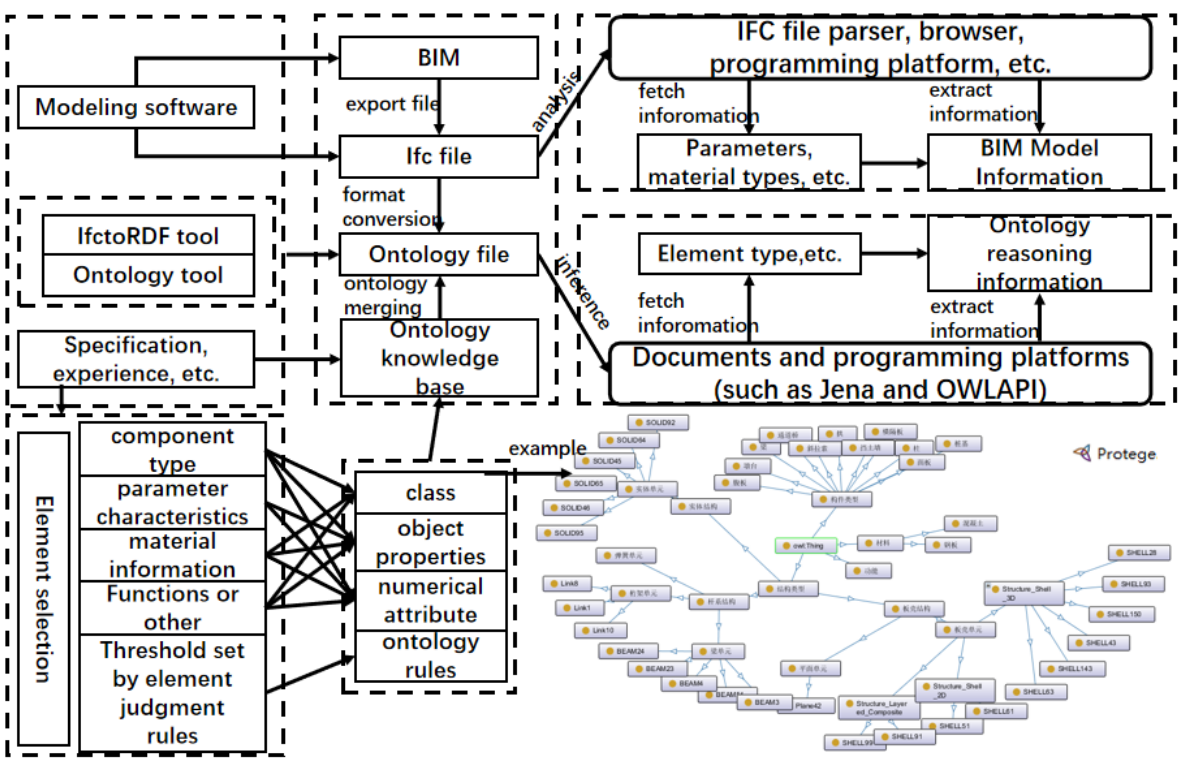
Figure 5. Framework of construction idea of the element type, data conversion, inference, and extraction based on BIM and ontology.